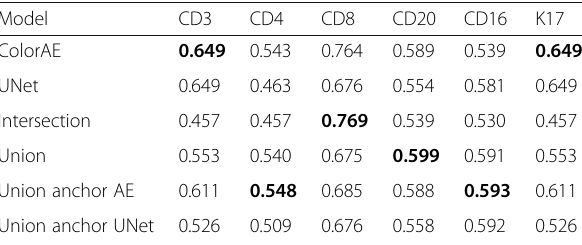
Table 5 DICE Scores evaluating predictions from UNet, ColorAE, and ensemble methods against per-pixel (hand-drawn)